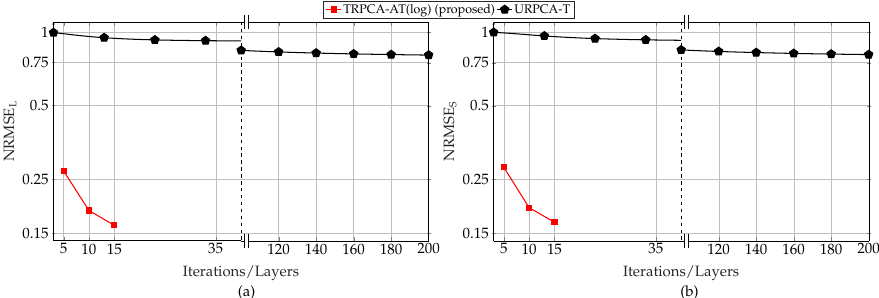
Figure 12. Average NRMSE of low-rank ( a ) and sparsity ( b ) contributions for experimental ultra- sounds data with 50% compression ratio for the proposed ADMM-based trained RPCA with adaptive thresholding based on logarithm heuristic (TRPCA-AT(log)) and ADMM-based untrained RPCA with thresholding